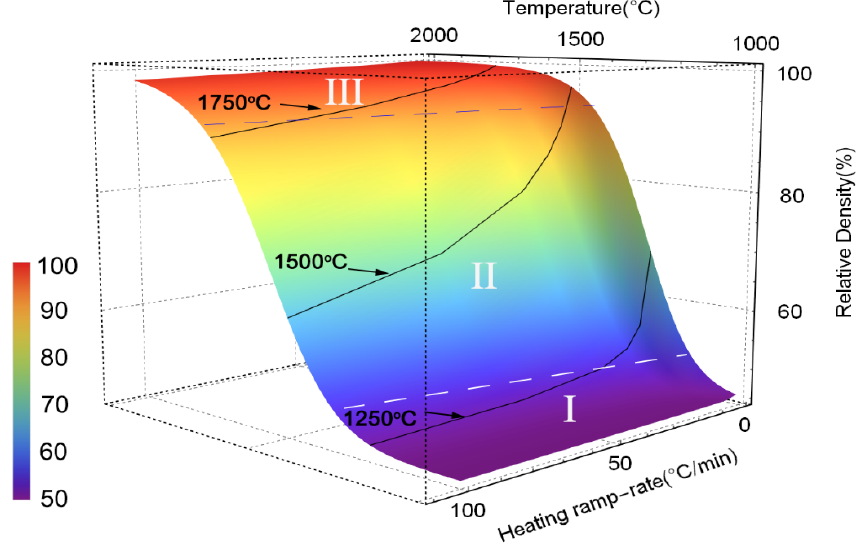
Figure 4. Predicted densification map using master sintering curve. Table 1. The experimentally measured and predicted relative density using master sintering curves for different sintering